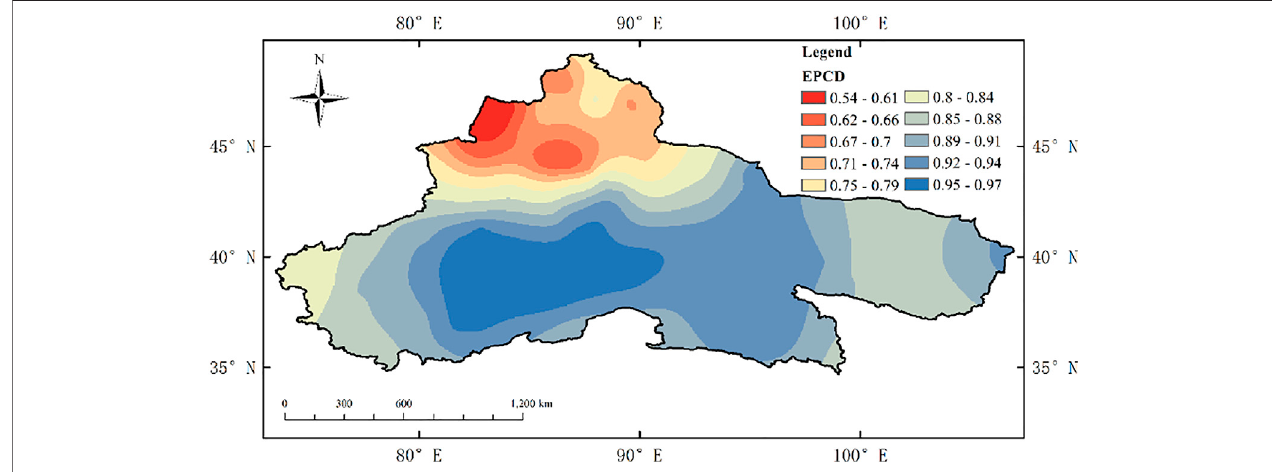
FIGURE 2 | Spatial distribution of mean annual extreme precipitation concentration degree (EPCD) during 1968 –